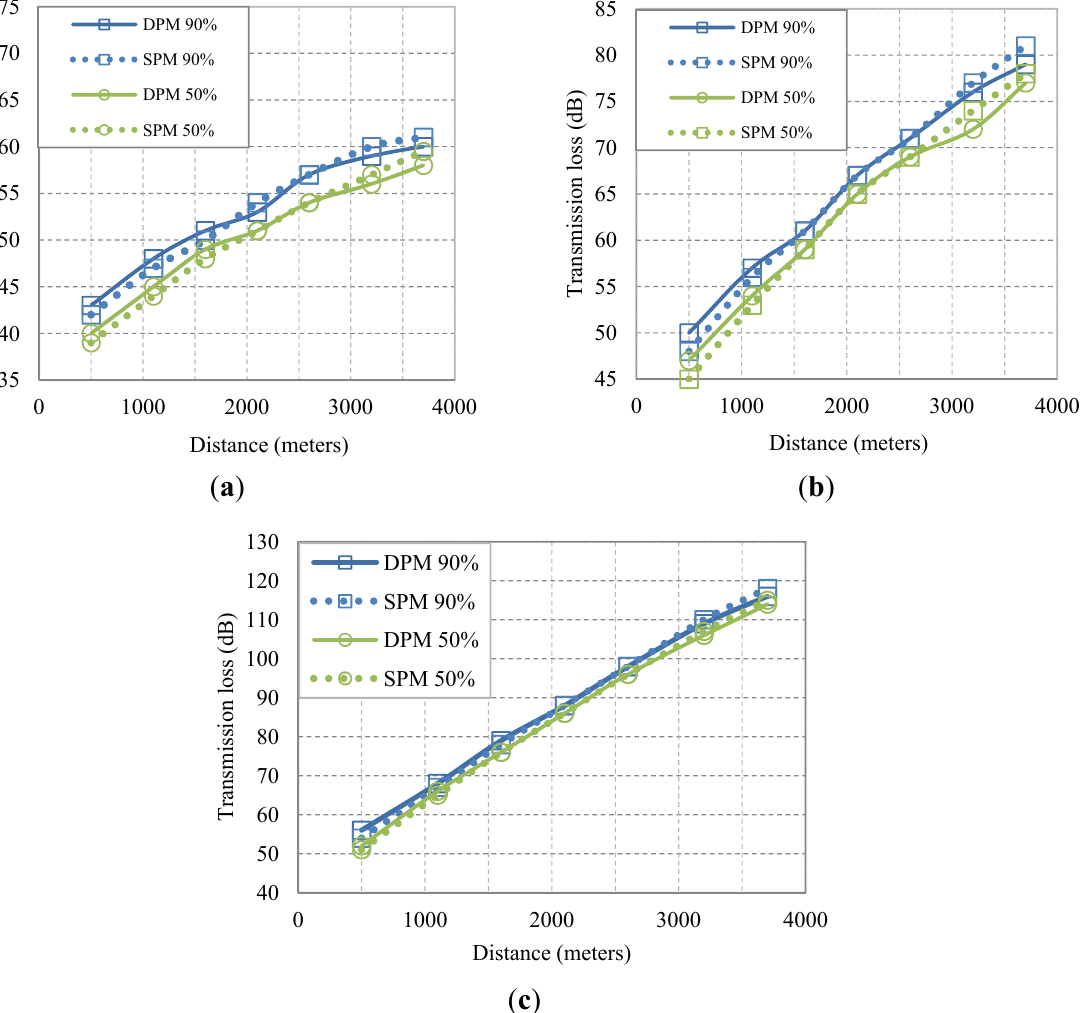
Figure 12. The transmission vs. distance curves with different power allocation schemes (50%, 90%). The solid and dashed curves show the results from the deterministic and the statistical propagation models, respectively. ( a ) 5–15 kHz, ( b ) 20–34 kHz, ( c ) 50–75